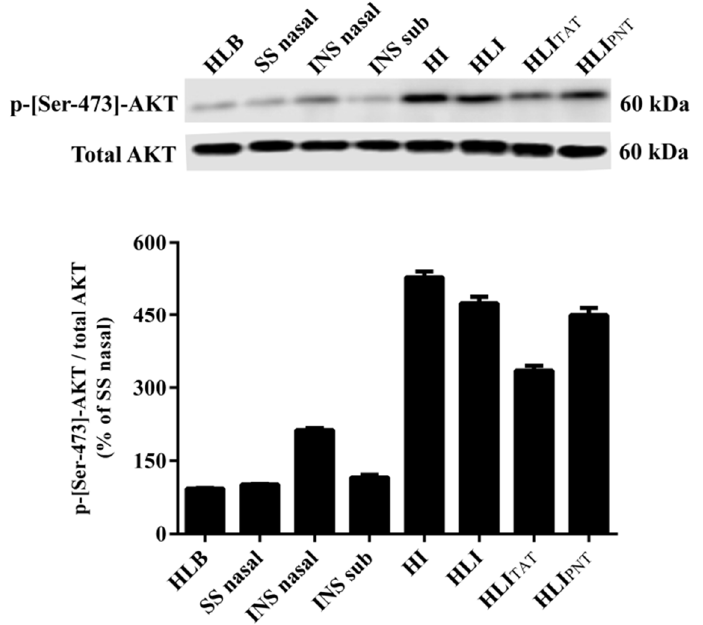
Figure 5. AKT phosphorylation levels (Ser-473) in anterior tibialis muscles of diabetic rats 360 min after intranasal administration of (i) intranasal administration of HEC-based hydrogels containing blank liposome (HLB); (ii) intranasal administration of saline (0.85% NaCl) (SS nasal ); (iii) intranasal administration of 2.0 IU insulin prepared in saline (INS nasal ); (iv) control group—subcutaneous administration of 2.0 IU insulin (Novolin R ® ) (INS sub ); (v) intranasal administration of HEC-based hydrogel containing 2.0 IU insulin (HI); (vi) intranasal administration of HEC-based hydrogels containing 2.0 IU insulin-loaded liposomes (HLI); (vii) intranasal administration of HEC-based hydrogels containing 2.0 IU insulin-loaded liposomes functionalized with TAT (HLI TAT ); (viii) intranasal administration of HEC-based hydrogels containing 2.0 IU insulin-loaded liposomes functionalized with PNT (HLI PNT ). The uncropped bolts are shown in Supplementary Materials.